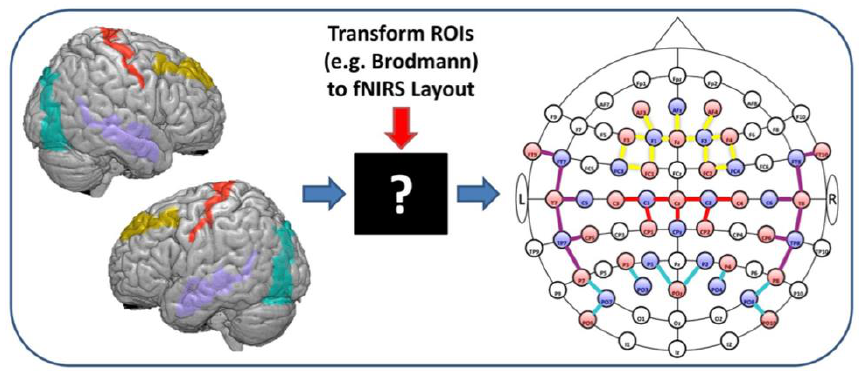
Figure 3. fNIRS cap layout with corresponding color-coded channels. Reproduced from reference [49].